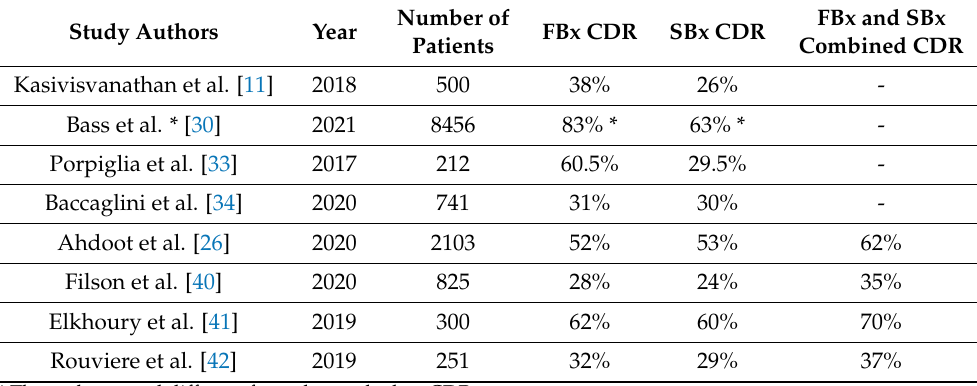
Table 1. Comparison of cancer detection rates of FBx, SBx, and the two approaches